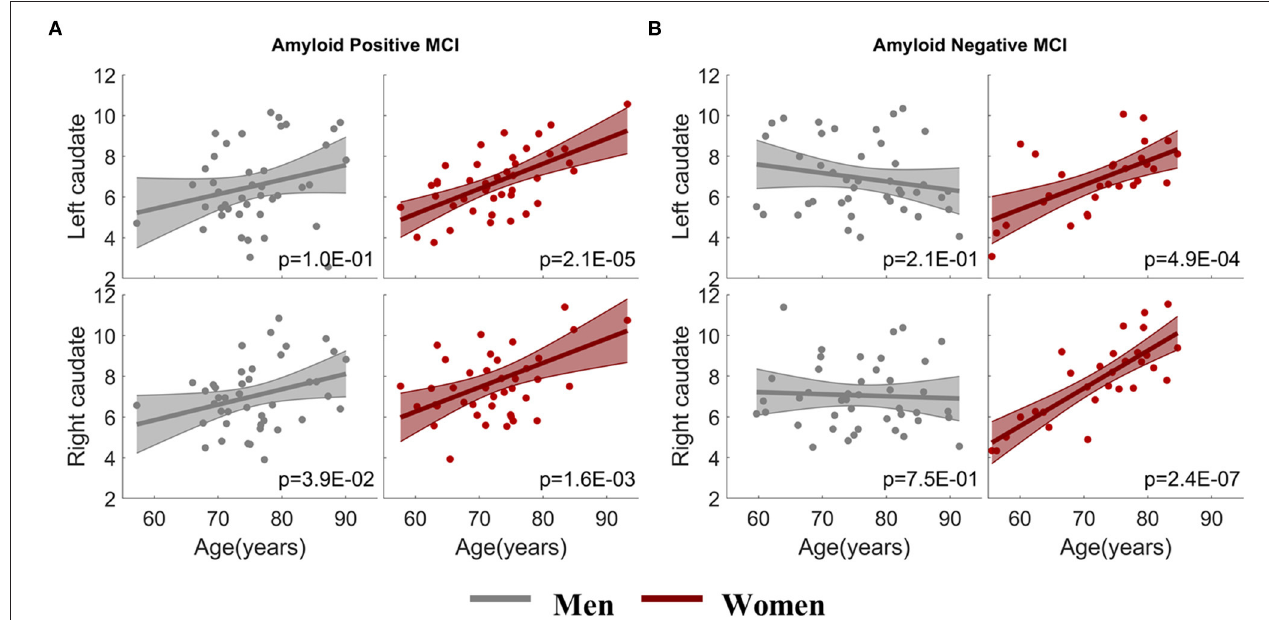
FIGURE 3 | Sex-dependent association analysis between caudate nodal strength and age with stratified amyloid status. (A) Association analysis within amyloid positive MCI participants. (B) Association analysis within amyloid negative MCI participants. The x-axis is age and the y-axis is the corrected caudate nodal strength after adjusting the influence of confounding